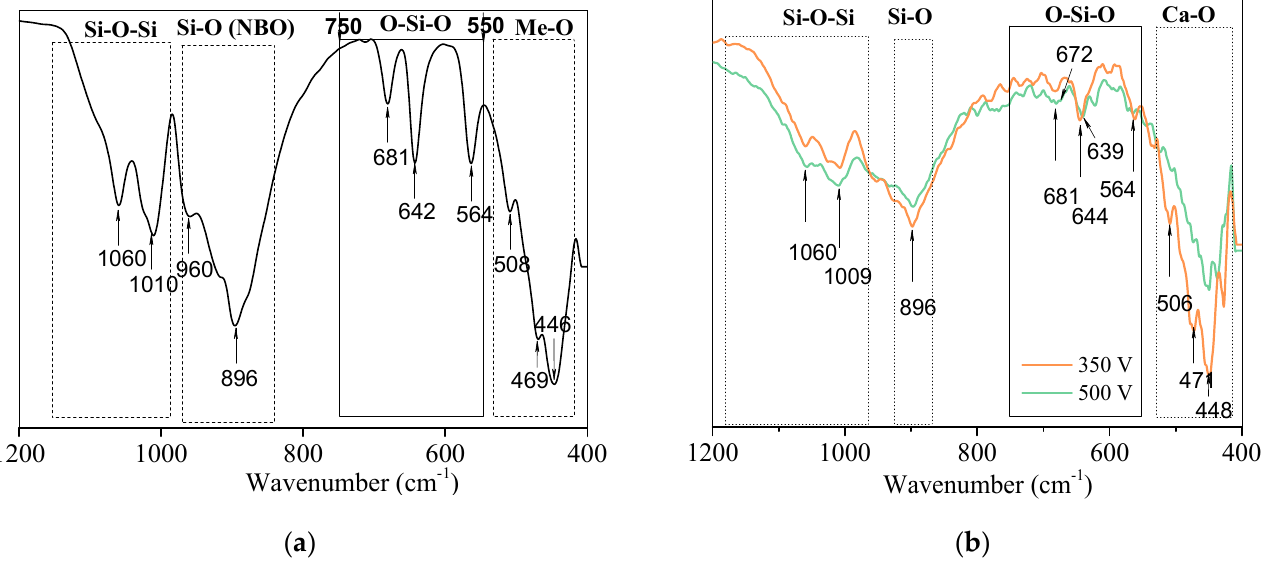
Figure 9. FTIR spectra of the wollastonite ( a ) and of the W-coatings deposited at the voltages 350 V and 500 V ( b ). 3.3. Bioresorption of the Pure Mg0.8Ca Alloy and W-Coatings The samples of the pure Mg0.8Ca and of the coated alloy were immersed in the 0.9% NaCl solution at 37 ◦ C for 16 days. It was revealed that the dissolution rate of the coated samples was significantly lower than that of the pure magnesium alloy (Figure 10a).